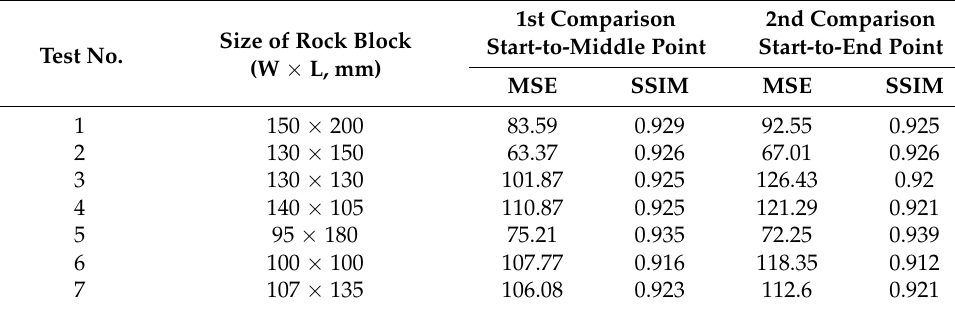
Table 2. Image quality assessment results.